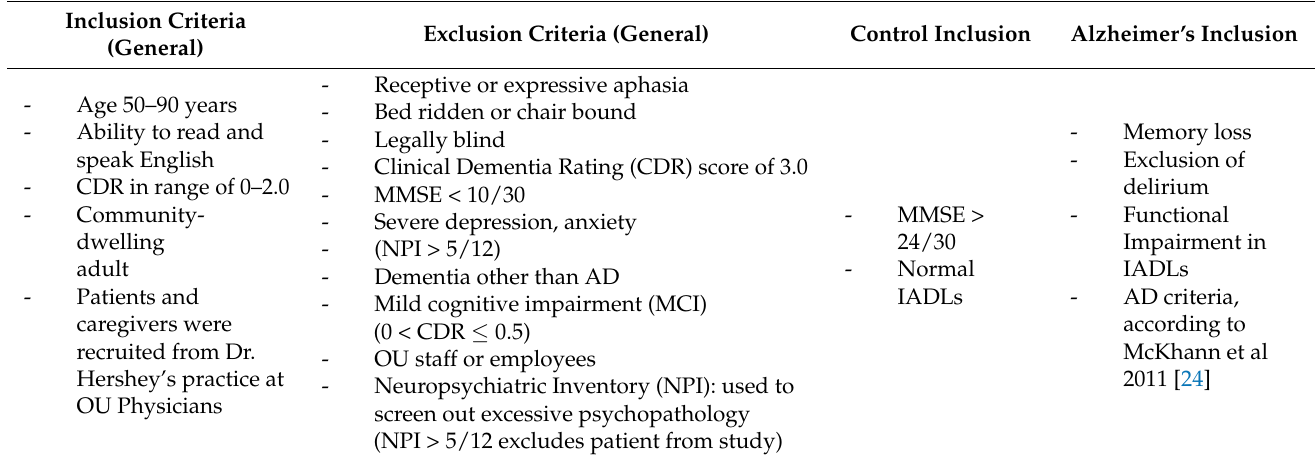
Table 1. Cont. Panel II, Inclusion/Exclusion Criteria for